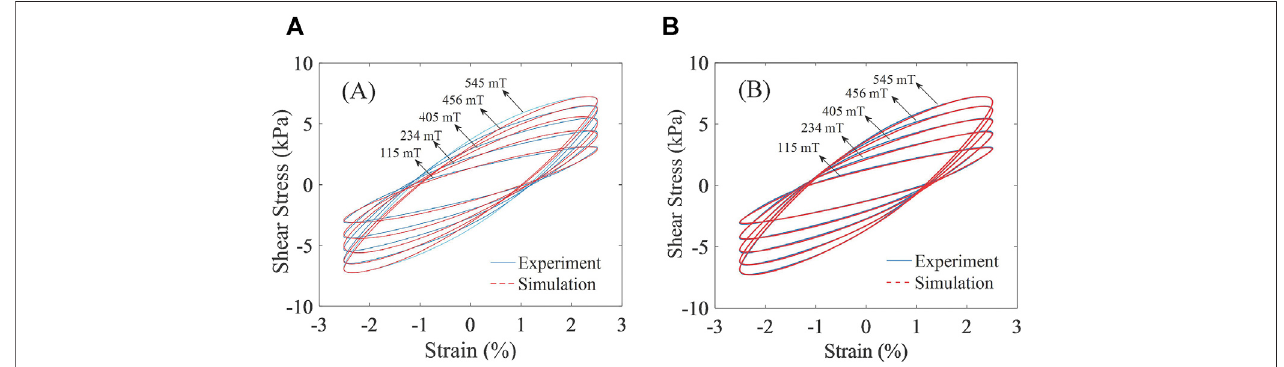
FIGURE 8 | Simulation data and experimental data under different magnetic fl ux density (A). Bouc-Wen model and (B) modi fi ed Bouc-Wen